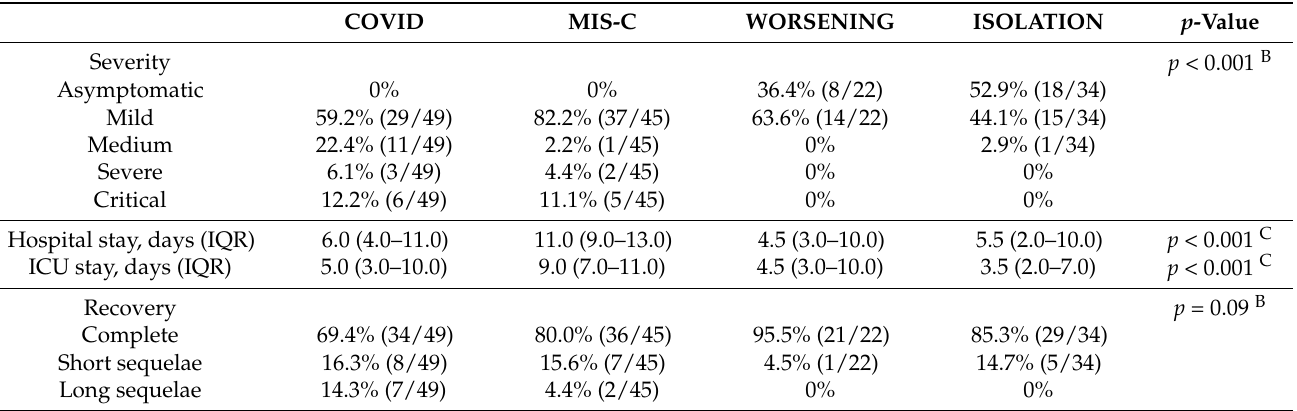
Table 2. Severity, length of hospitalisation, and recovery.